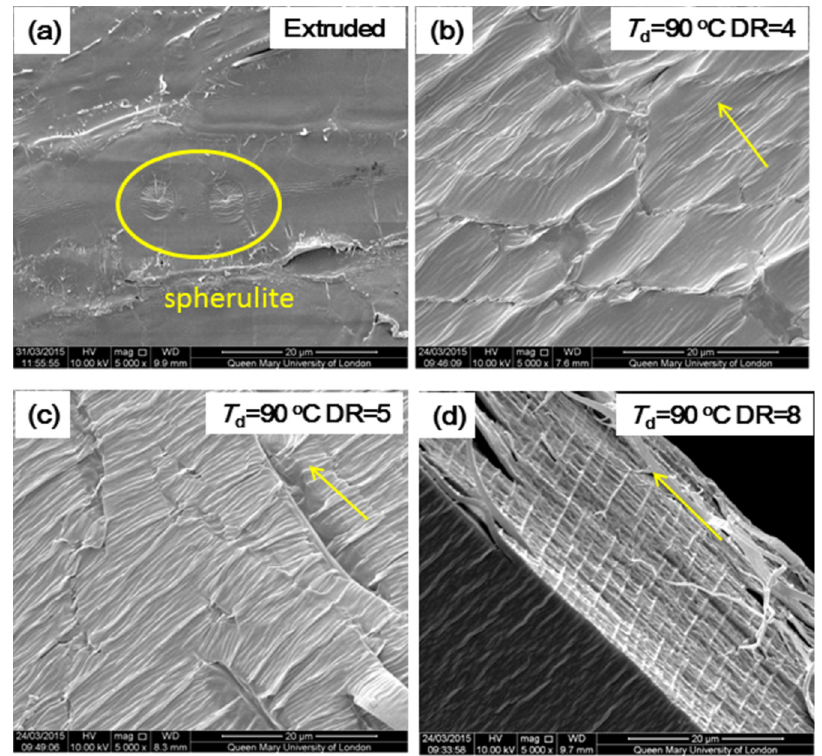
Figure 9. Scanning electron microscopy (SEM) cross-section images of ( a ) as-extruded tape and tapes drawn at 90 °C with ( b ) DR = 4; ( c ) DR = 5; and ( d ) DR = 8. Arrows indicate the stretching